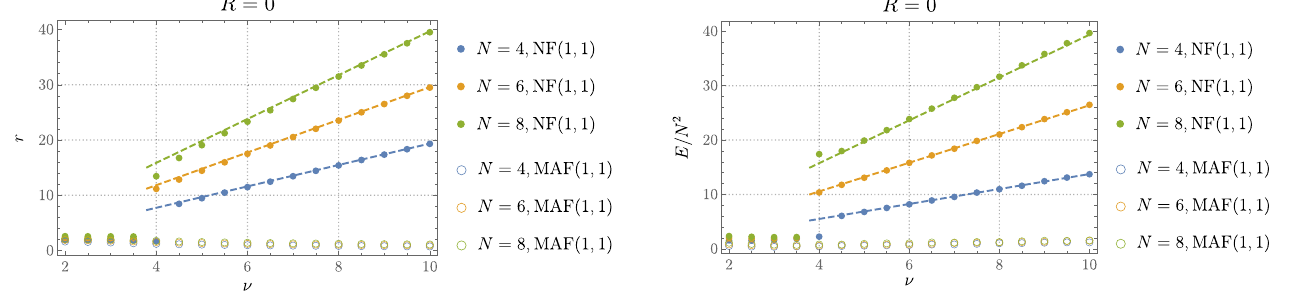
FIG. 3. Variational energies in the zero fermion sector of the mini-BMN model, for different N and ν . The dashed lines are ν ð N 2 − 1 Þ þ Δ E j semiclassical values: E ¼ − 3 , with Δ E j 2 bos bos given in Eq. (4.8). As in Fig. 2, solid dots are initialized near the fuzzy sphere configuration, and the open markers are initialized near